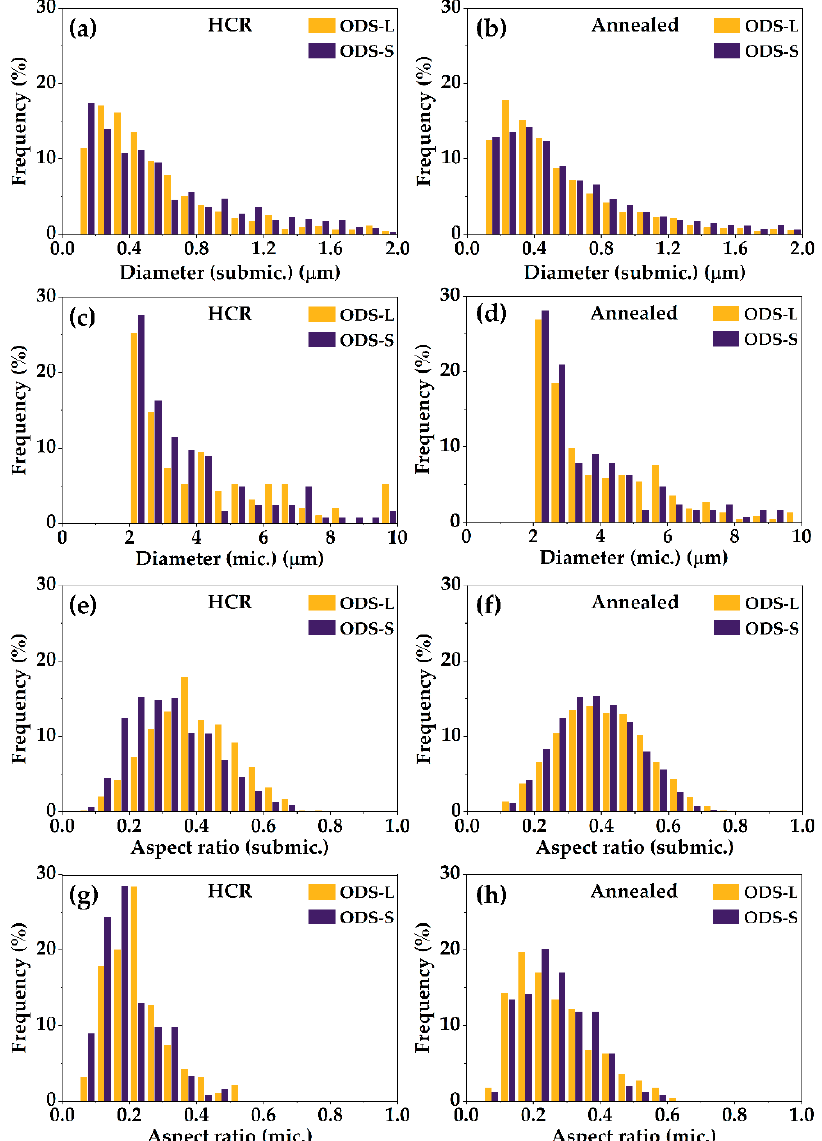
Figure 6. UGC maps of the ODS steels after HCR and after annealing at 1273 K: ( a ) ODS-L steel after HCR, ( b ) ODS-S steel after HCR, ( c ) ODS-L steel after annealing, and ( d ) ODS-S steel after annealing. The maps were taken along the TS plane.